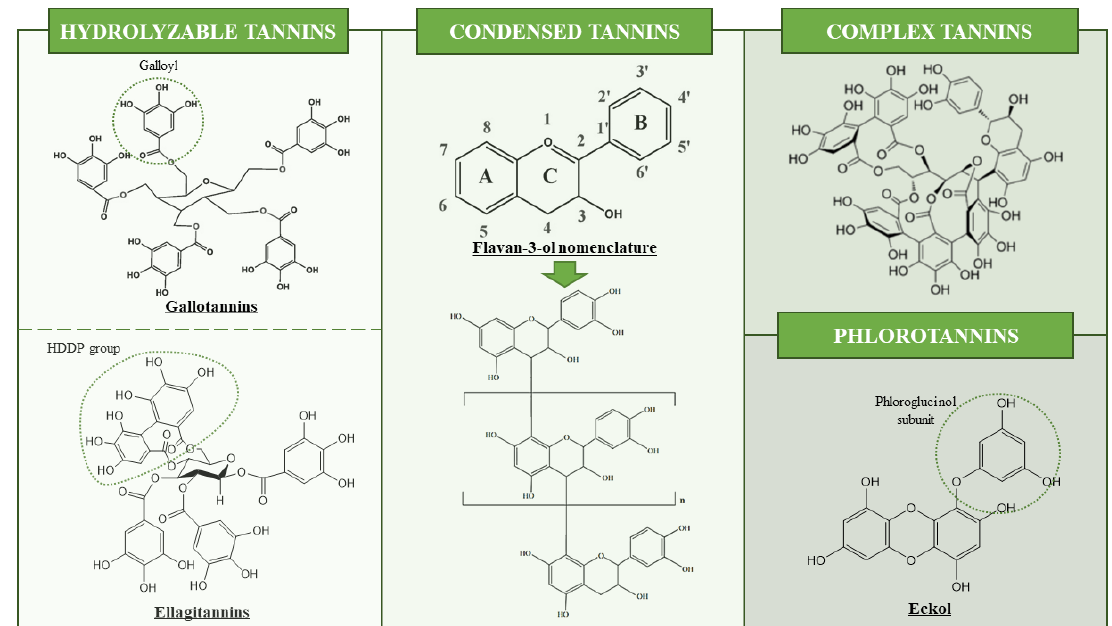
Figure 1. Structural classification of tannins. Functional groups are shown in circles. HTs have owned their name as they can be hydrolyzed by weak acids/bases, producing carbohydrates and phenolic acids because of the reaction [3]. They are formed by glycosylated gallic acid units [9], which can be either ellagic acid (EA) or gallic acid (GA), forming ellagitannins (ETs) and gallotannins (GTs), respectively [3,10]. ETs are formed by simple to multiple units of hexahydroxydiphenol (HHDP) connected to a polyol core. After hydrolysis and the breakdown of C-C bonds between suitably orientated galloyl residues of glucogalloyl molecules of HHDP, they are converted into EA units [2,11,12]. The abundant variety of structure has been observed within this group, due to the different possibilities in the formation of oxidative linkages [7]. On the other hand, GTs are considered as simpler HTs and are formed by galloyl or digalloyl units coupled to a polyol, catechin or triterpenoid unit, in the form of pentagalloyl glucose (PGG). They can yield GA from the hydrolysis reaction [2,13]. HTs can be mainly found in fruits, berries, legumes, leafy vegetables and different tree species [3,9]. They have been widely employed in the leather industry and they have been studied for their antioxidant and antimicrobial properties [3]. CTs or proanthocyanidins account for more than 90% of the world commercial production of tannins [3]. They are polymeric or oligomeric flavan-3-ols, formed by the combination of A (phloroglucinol or resorcinol) and B (catechol or pyrogallol) rings [2,14] (Figure 1). When these compounds are heated in ethanol solutions in acidic conditions, they are decomposed into anthocyanidins [7]. The combination of these flavan-3-ol monomers gives rise to the formation of procyanidins (PCs) (composed of catequins and epicatechins) or profisetinidin, prorobinetidin and prodelphindin (composed of